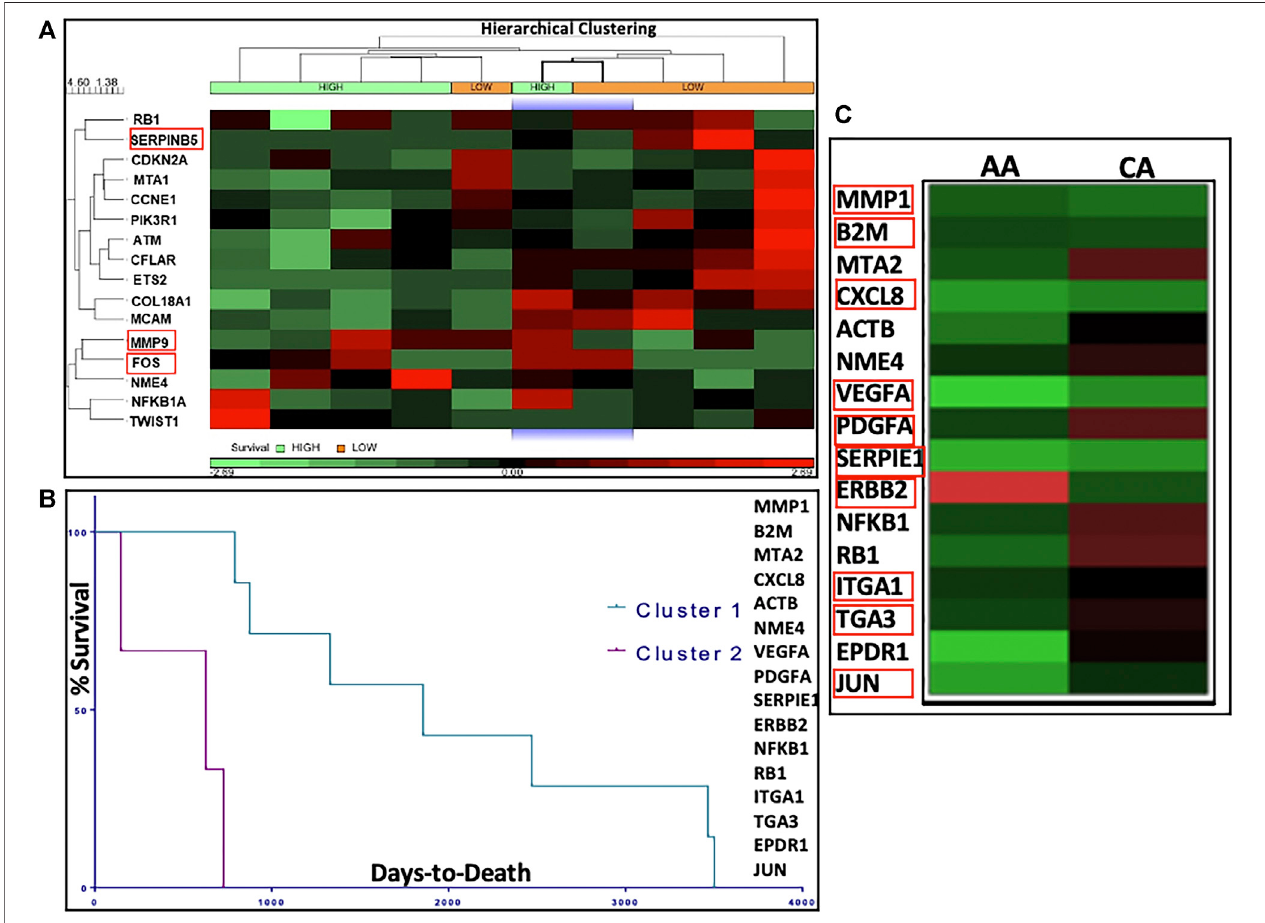
FIGURE5| InsilicocorrelationofMETRO-TOPOtreatmentsignaturesusingTheCancerGenomeAtlas(TCGA)database. (A) Heatmaprepresentsdifferentialgene expressionofMETRO-TOPOgenesbetweenHighvsLowsurvivalprostatecancer(PRAD)subgroupsinTCGAdatabase.Hierarchicalclustering(HC)analysiswasused to group row-level (genes) and column-level (patient samples) based on differential gene expression. Differential expression of MMP9, FOS and SERPINB5 were signi fi cantly associated with patient survival. (B) Kaplan-Meier plots showed strati fi cation in survival among the TCGA prostate cancer patient clusters. K-means clusters (class (cid:1) 2) were generated based on the highly differentially expressed genes (DEGs) for METRO-TOPO treatment. (C) Heatmap represents differential gene expression between AA (African American) and CA (Caucasian American) men for the top DEGs (MMP1, B2M, CXLC8, VEGF, PDGFA, SERPINE1, ERBB2, ITGA1, ITGA3 and